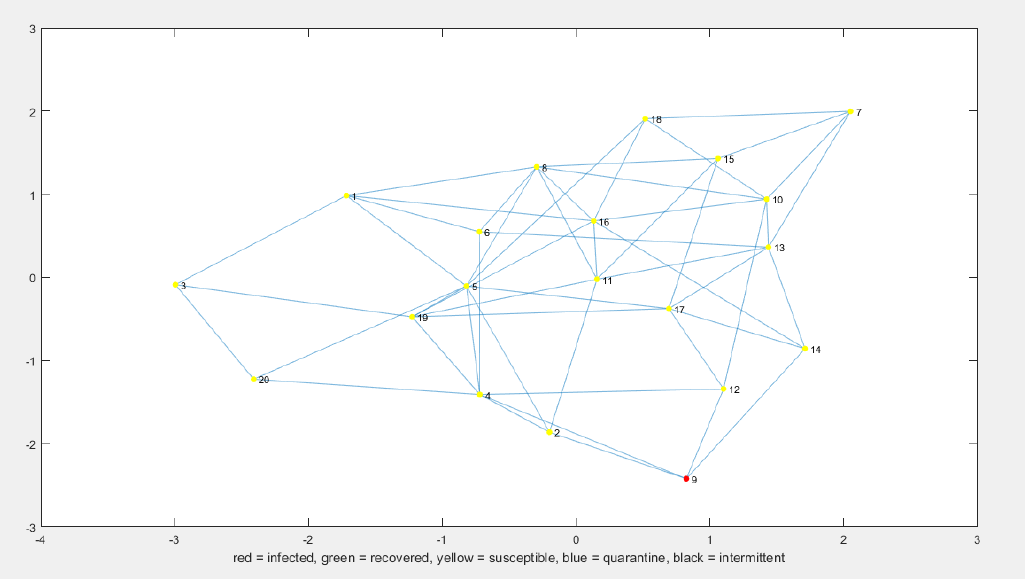
Figure 7. Node-state graph at time t = 0.